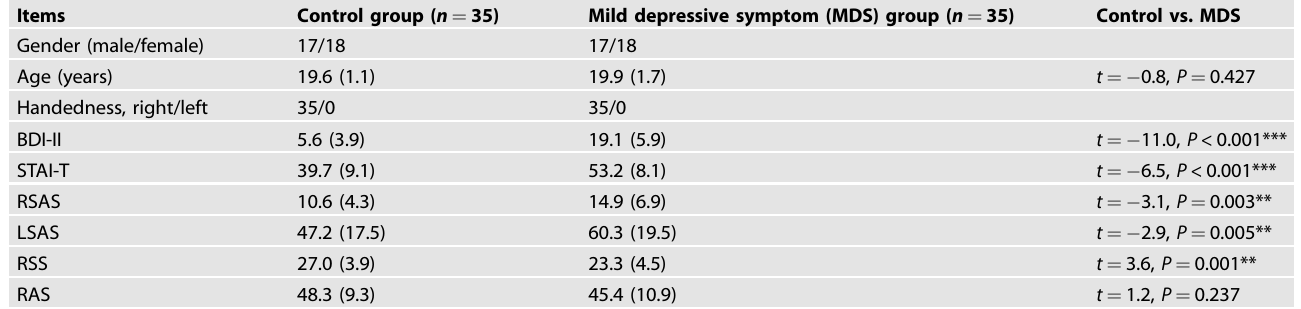
BDI-II the Beck Depression Inventory Second Edition, STAI-T the Trait form of Spielberger ’ s State-Trait Anxiety Inventory, RSAS the Revised Social Anhedonia Scale, LSAS Liebowitz ’ s Social Anxiety Scale, RSS Rosenberg Self-esteem Scale, RAS the hedonic factor of Robot Acceptance Scale. ** P <0.01, *** P <